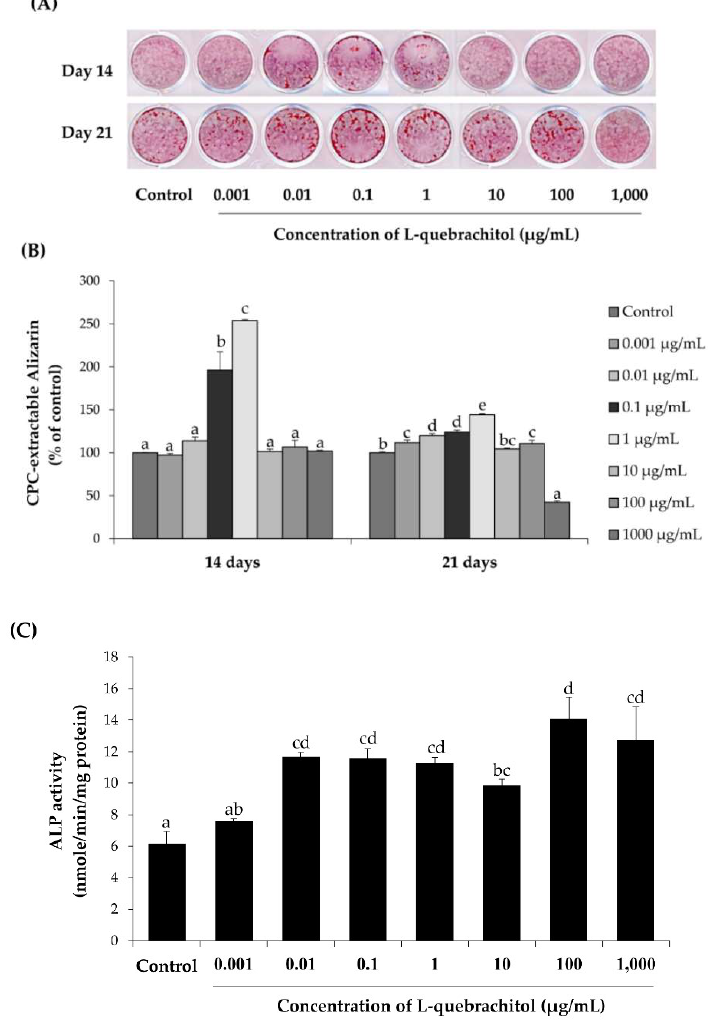
Figure 4. The effect of L -quebrachitol at the concentration of 0.001, 0.01, 0.1, 1, 10, 100, and 1000 µg/mL on osteogenic differentiation and mineralization in MC3T3-E1 cells. ( A ) MC3T3-E1 cells were treated